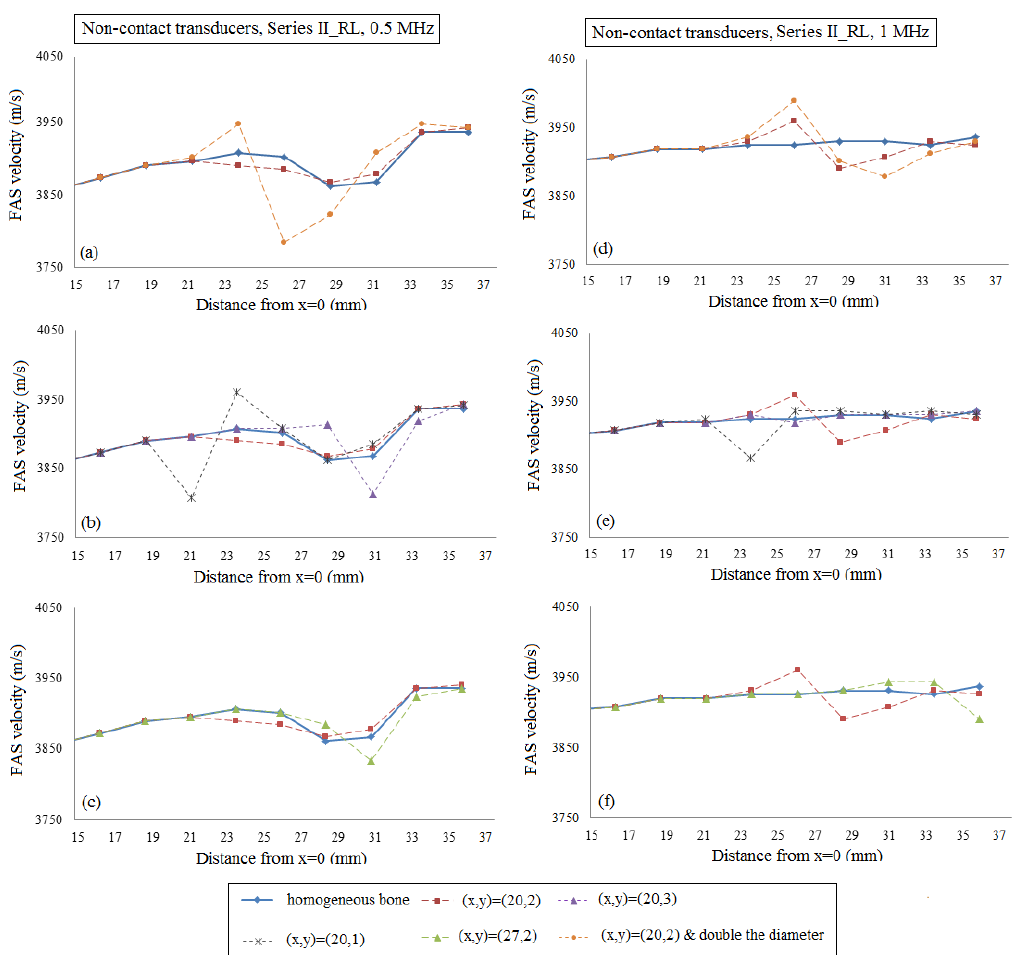
Figure 11. The potential of the local FAS velocity to detect the occurrence of a single RL considering cortical bone as a homogeneous medium (geometries illustrated in Figure 3a–e). The diagrams correspond to the second set of simulations when the transducers are placed at a distance of 2 mm from the cortical cortex. The results for the excitation frequencies : ( a )–( c ) 0.5 MHz; and ( d )–( f ) 1 MHz are presented. The legend describes the center coordinates of the RL.